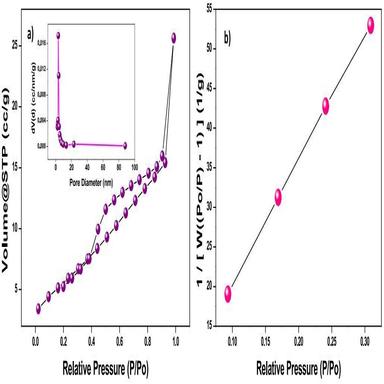
BET isotherm plot a) N2 adsorption-desorption and Inset: pore size distribution of ILβ-MNV b) vs relative pressure.